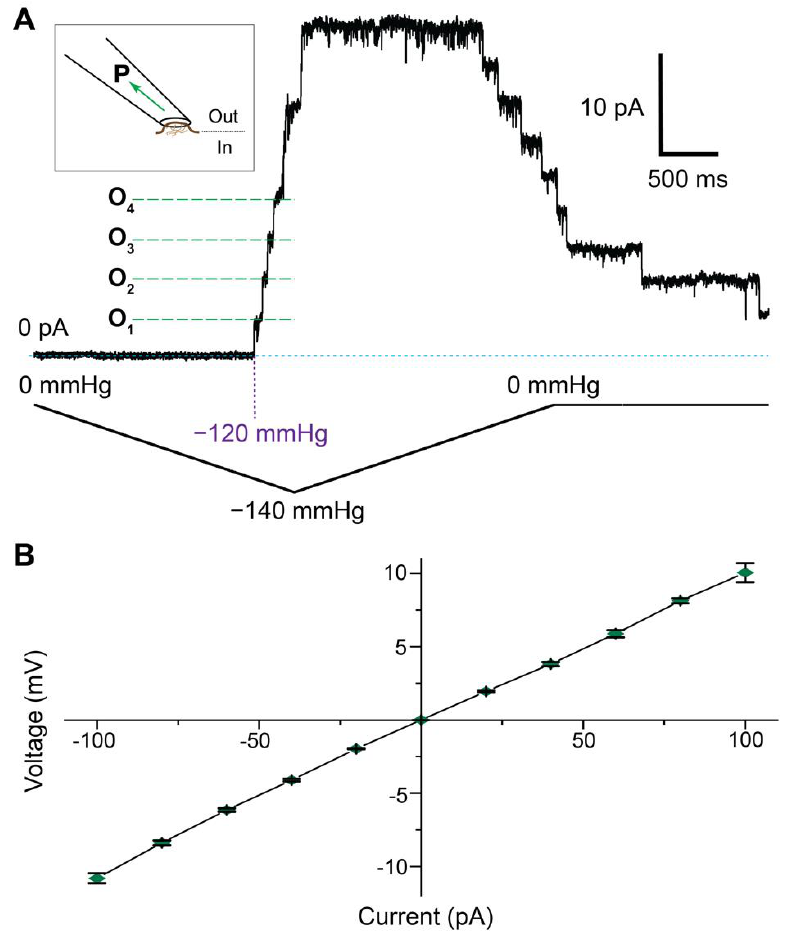
Figure 5. Ion channel activity of OzTrac-MSL10-34 expressed in Xenopus laevis oocytes. ( A ) Pressure ramp of an inside-out patch excised from oocytes. Schematic in upper left depicts excised patch of membrane; outer leaflet of the plasma membrane faces the interior of the pipette. Negative pressure (P) or suction was applied during patch clamp recordings. Example channel opening events (O n ) are annotated and marked by green dotted lines, and pressure is given in millimeters of mercury (mmHg). Membrane potential = − 40 mV. Note channel hysteresis, as previously described for At MSL10. ( B ) Current-voltage plot of currents observed in stretch-activated membrane patches. Unitary (single-channel) conductances were similar to published data for unmodified AtMSL10. Error bars: SEM ( n = 2 – 17 excised patches).